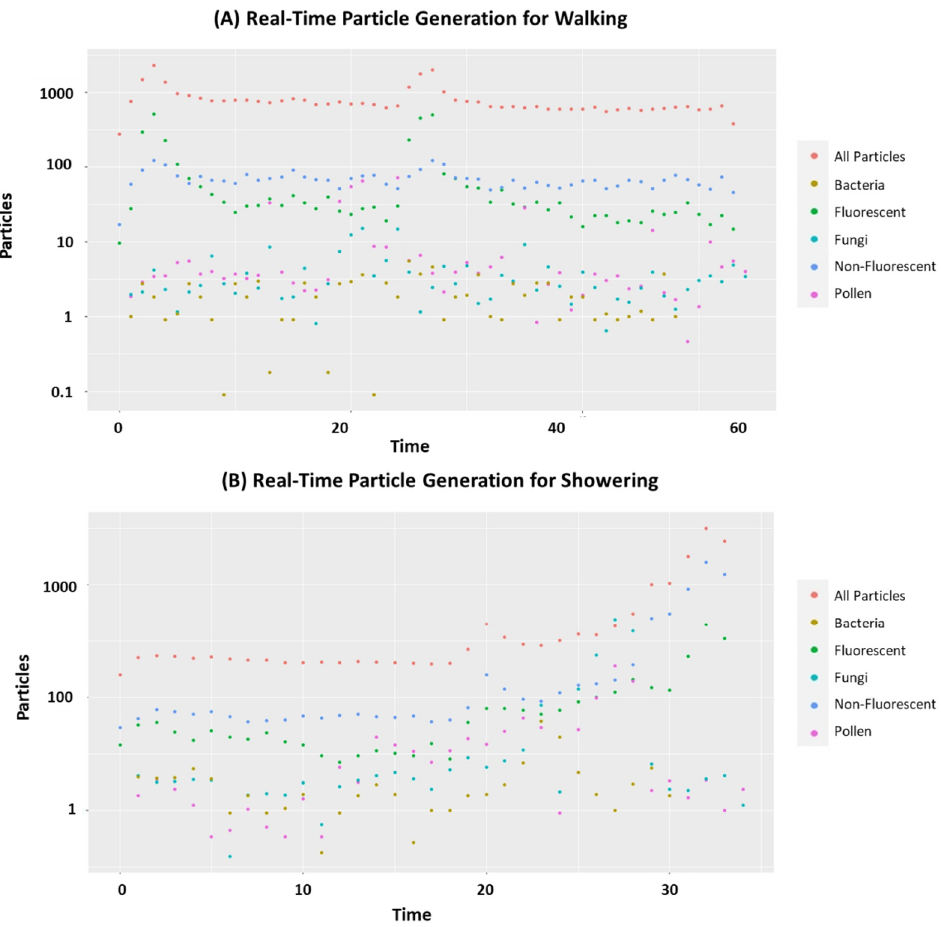
Figure 5. Real-time particle concentrations on log scale over time for one replicate of both ( A ) walking and ( B ) showering activities.